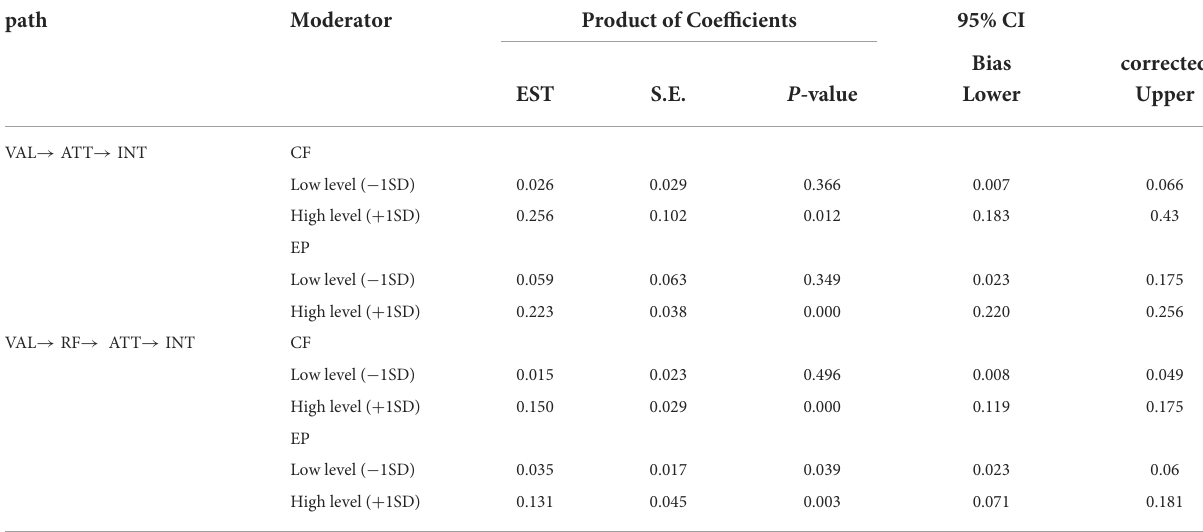
TABLE 10 Moderated mediation